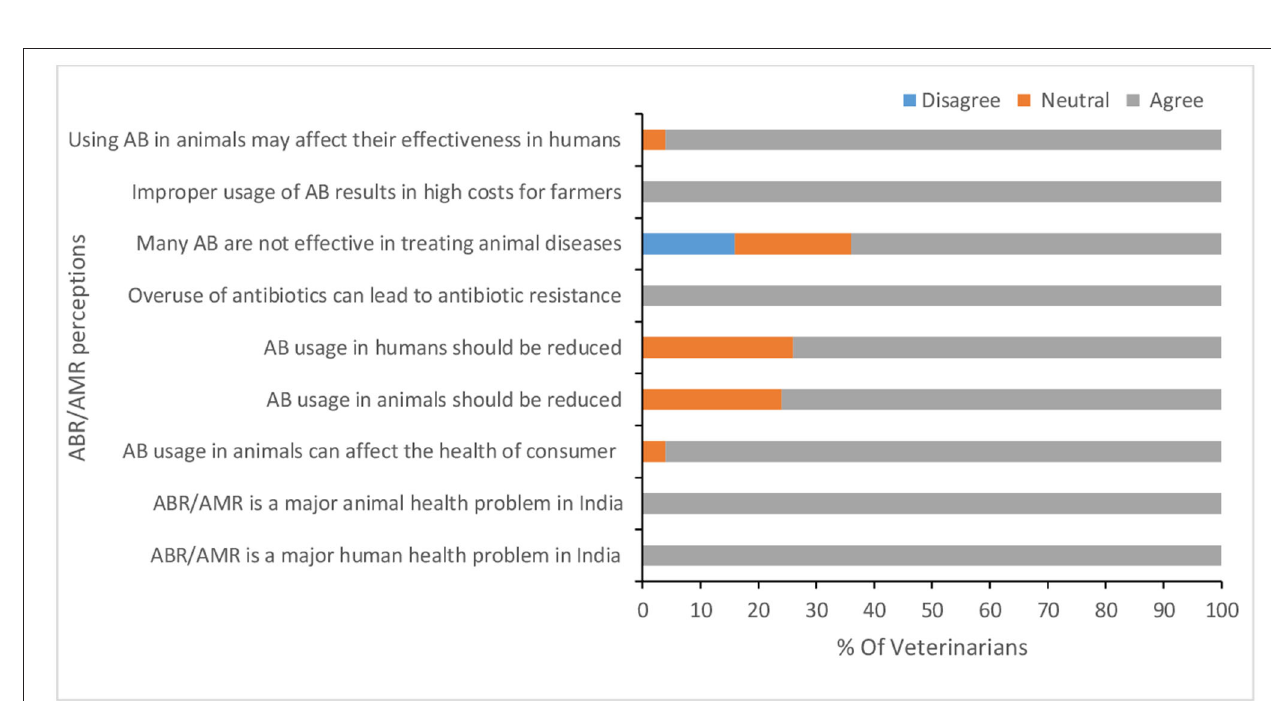
Frontiers in Veterinary Science |